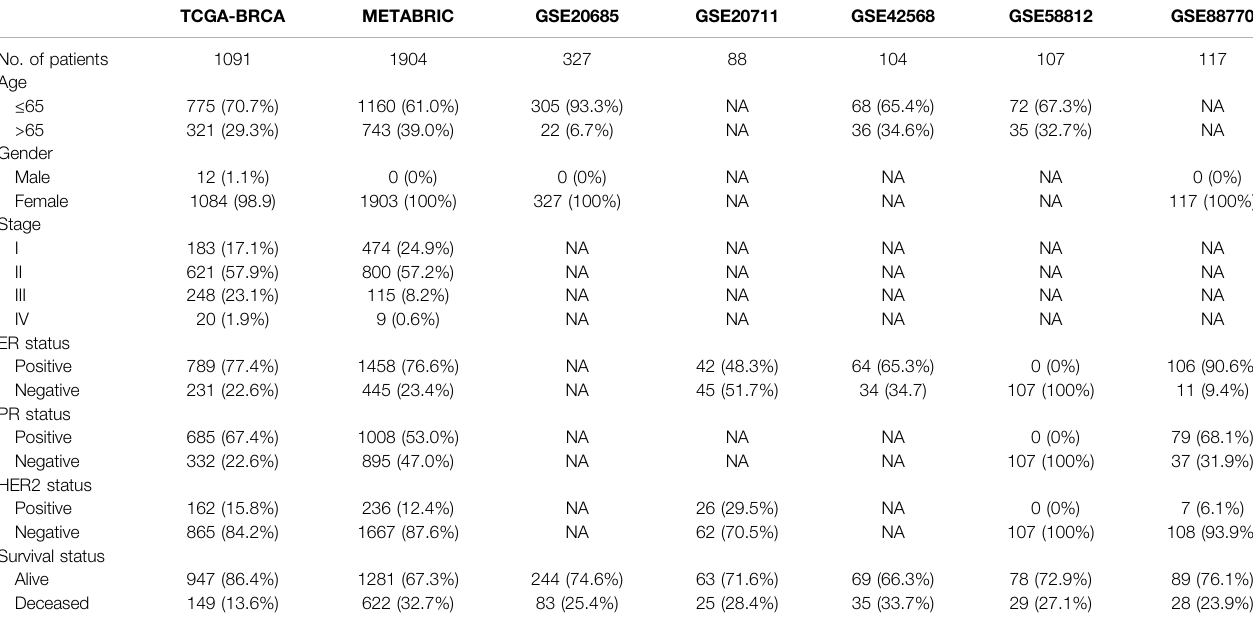
TABLE 1 | Baseline characteristics of breast cancer patients in TCGA, METABRIC and GSE